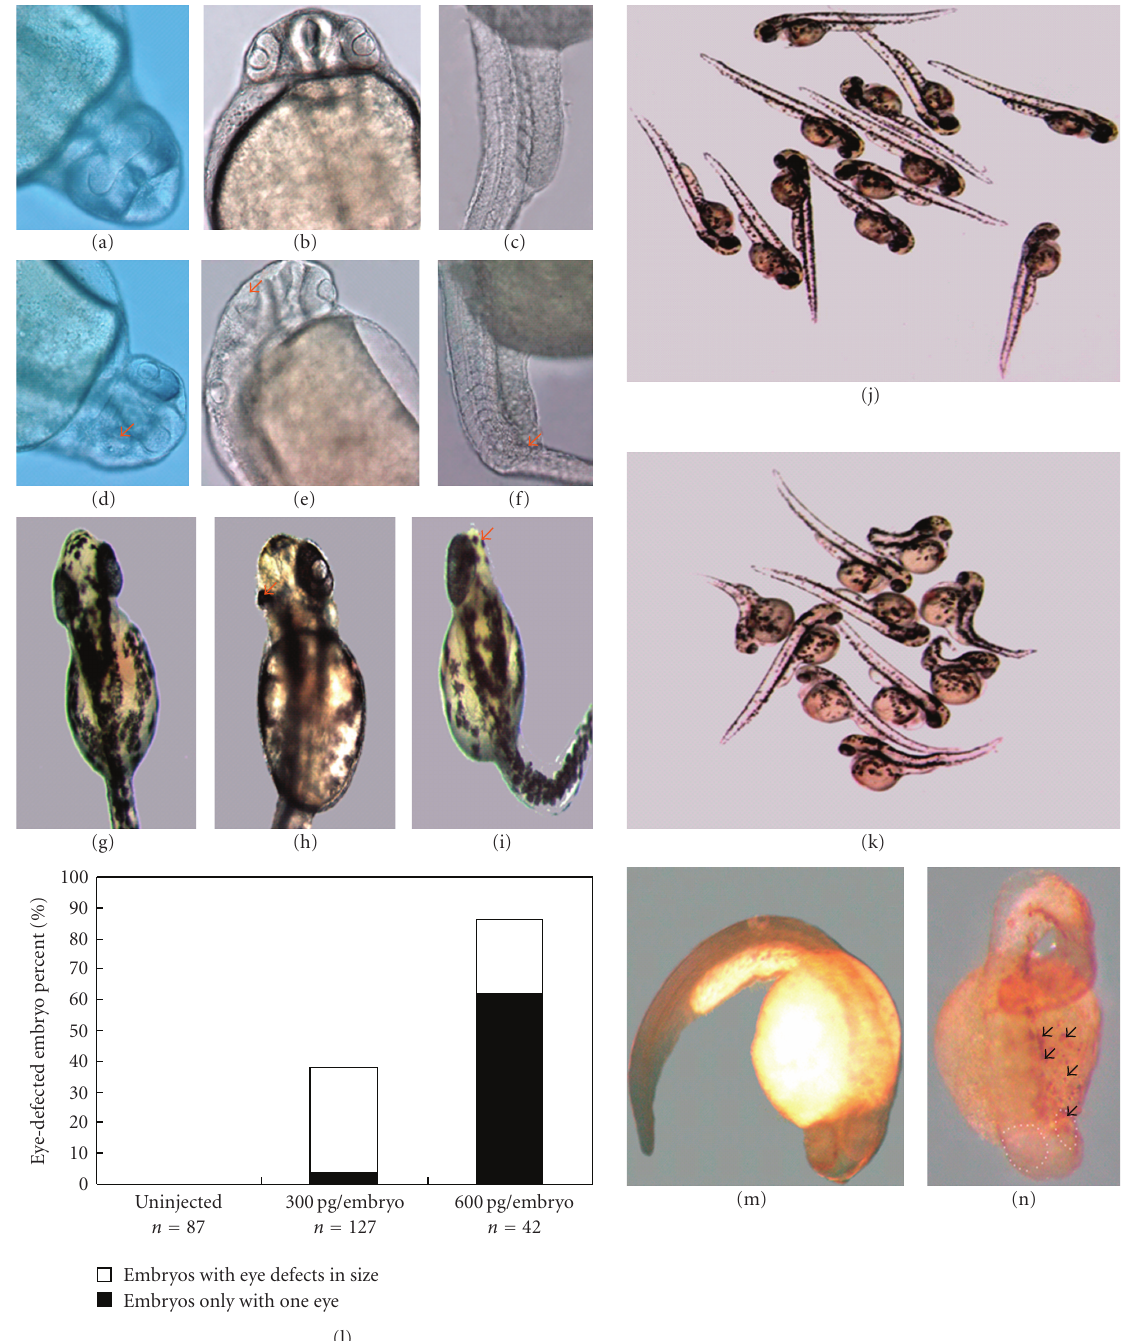
Figure 4: Heterologous expression of xPNAS-4 causes eye defects in zebrafish embryos. Embryos were injected at the one-cell stage with 300pg or 600pg of xPNAS-4 mRNA. Figures 4(a)–4(f) show embryos at 24 hours post fertilization (hpf). (a) Ventral view of a wild type zebrafish embryo with anterior to the bottom right. (b) Ventral view of a wild type zebrafish embryo with anterior to the top. (c) Lateral view of the normal axis of a wild type embryo. (d) Ventral view of a reduced-eye embryo. Arrow indicates the reduced eye. (e) Ventral view of a one-eyed embryo with anterior to the top. Arrow indicates the lost eye. (f) Lateral view of bent axis defects (arrow) of xPNAS-4 mRNA injected embryo. Figures 4(g)–4(i) show embryos at 48 hpf with anterior to the top. (g) Dorsal view of a wild type zebrafish embryo. (h) Dorsal view of an embryo with a reduced size eye. (i) Dorsal view of a one-eyed embryo. (j) Population of wild type zebrafish embryos at 48hpf. (k) Population of zebrafish embryos with eye defects at 48hpf. (l) Quantitative data for eye defects in injected and uninjected zebrafish embryos at 48hpf. N is the number of embryos examined for each treatment. (m) Whole-mount TUNEL staining of a wild type embryo at 24 hpf. (n) Whole-mount TUNEL staining of an embryo with an eye defect at 24hpf. A high number of TUNEL-positive cells were detected on the side of injection (black arrow). Dotted circle indicates the developing